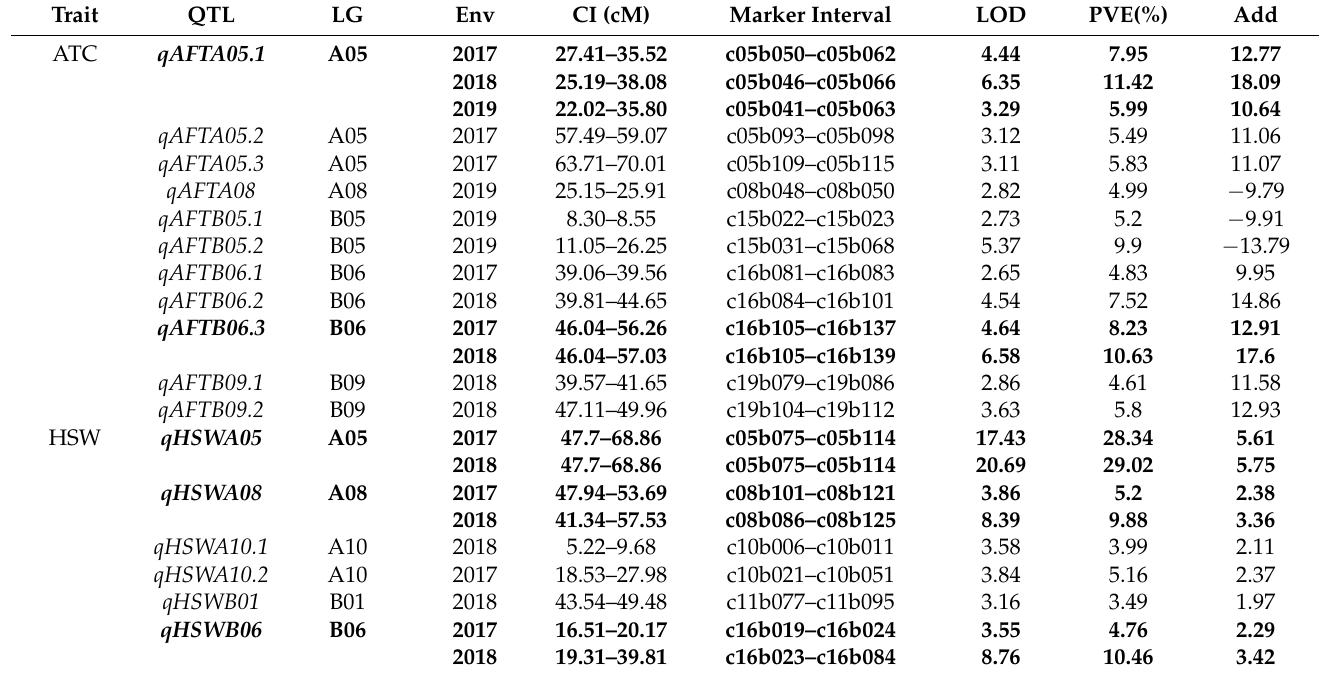
Table 4. Additive QTLs for resistance to ATC and HSW in the RIL population across three and two